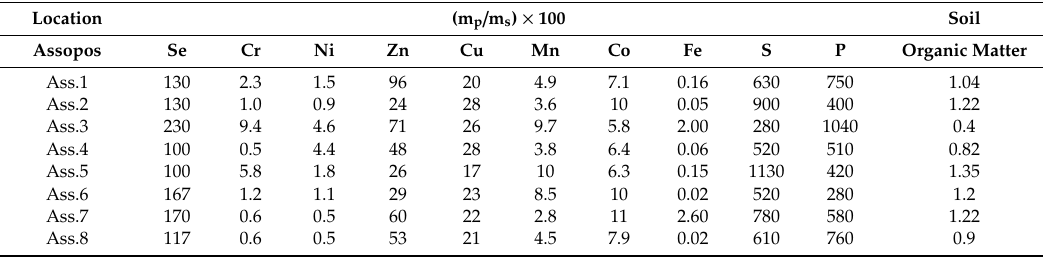
Table 3. Percentage of soil Se and metals in plants from Neogene Basins of Greece. Data from Tables 1 and